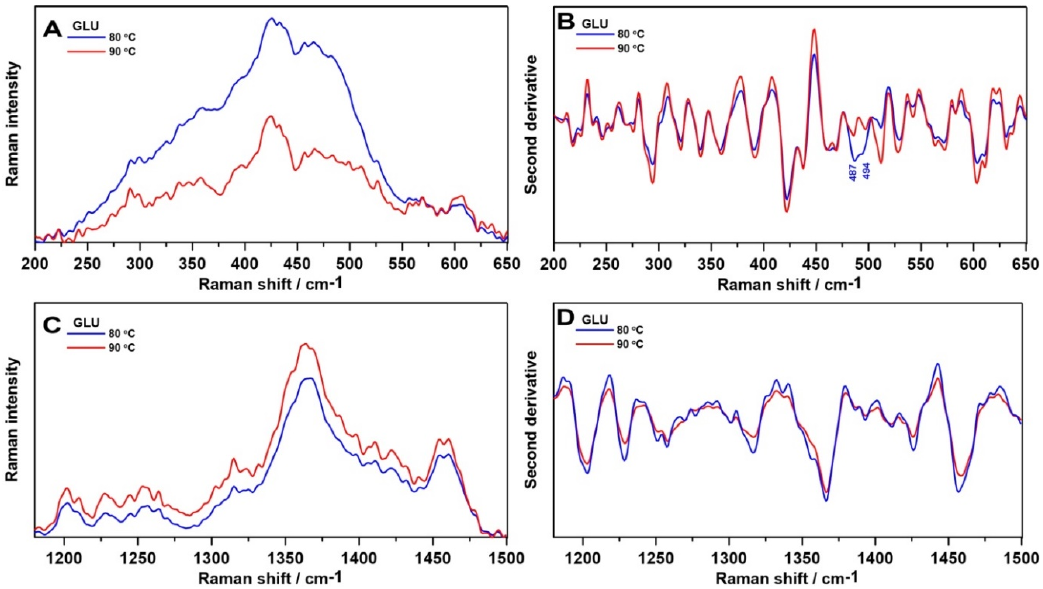
Figure 5. The relative intensity of Raman spectra in the 200–650 cm − 1 ( A ) and 1180–1500 cm − 1 range ( B ), and the second derivatives of the Raman spectra in these ranges ( C , D , respectively).